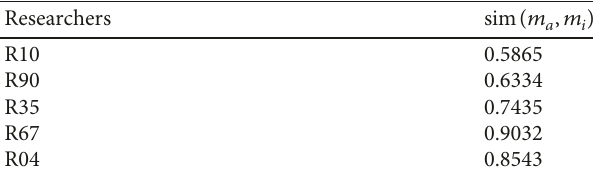
Table 3: University students’ R01 neighboring